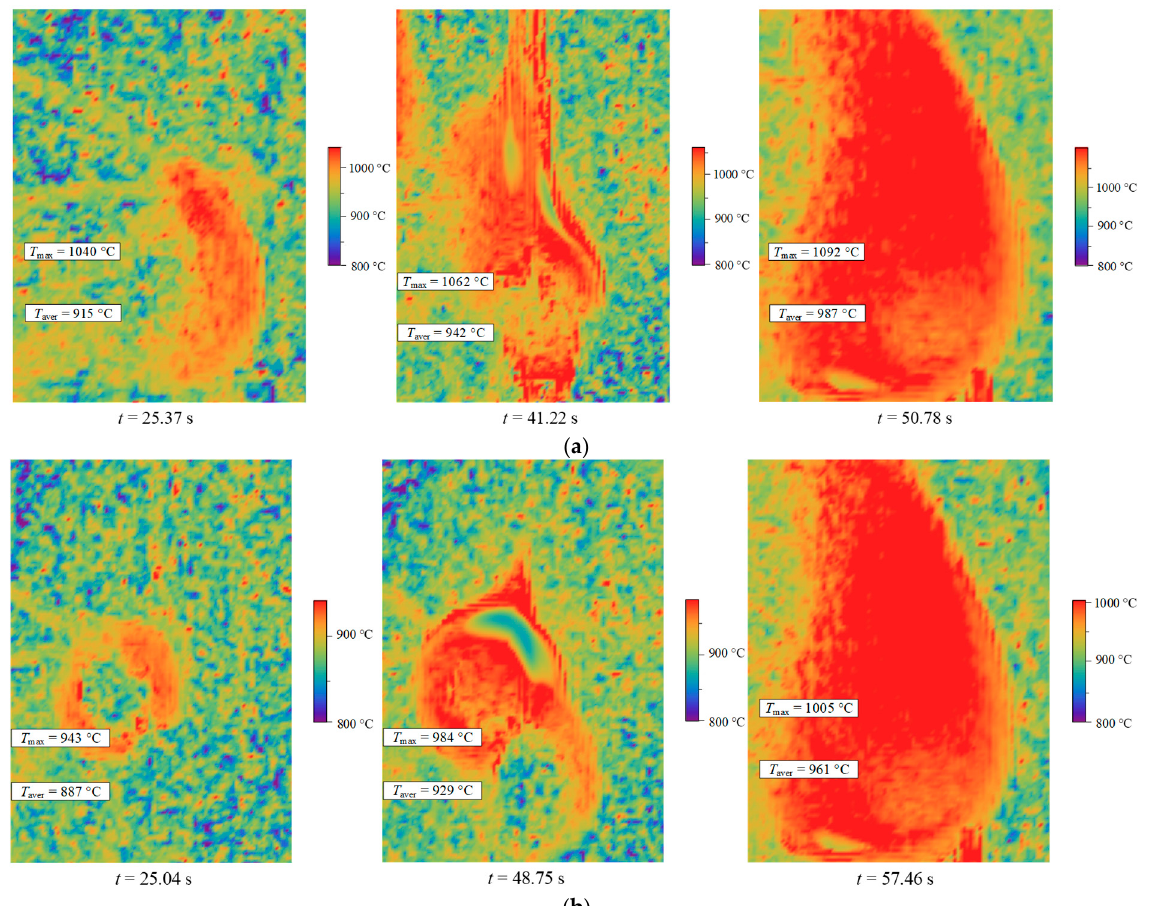
Figure 6. Typical temperature fields in the process of slurry fuel combustion with syngas ( a ) and without it ( b ).